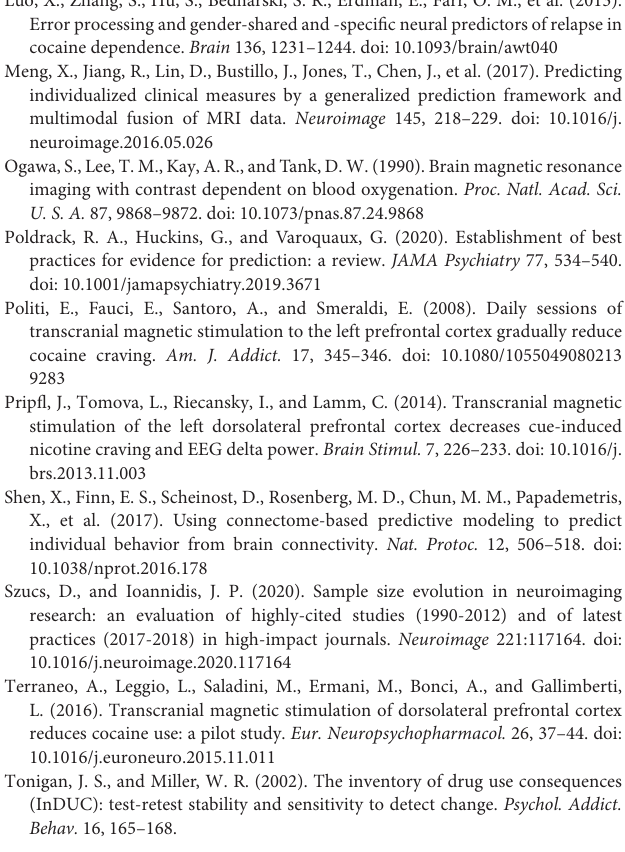
algorithm validation with a limited sample size. PLoS One 14:e0224365. doi: